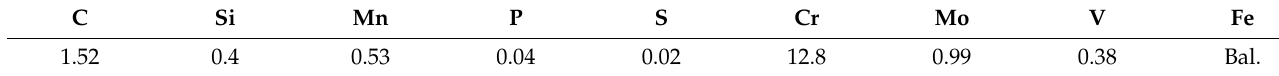
Table 1. Chemical composition of AISI D2 steel (wt.%).